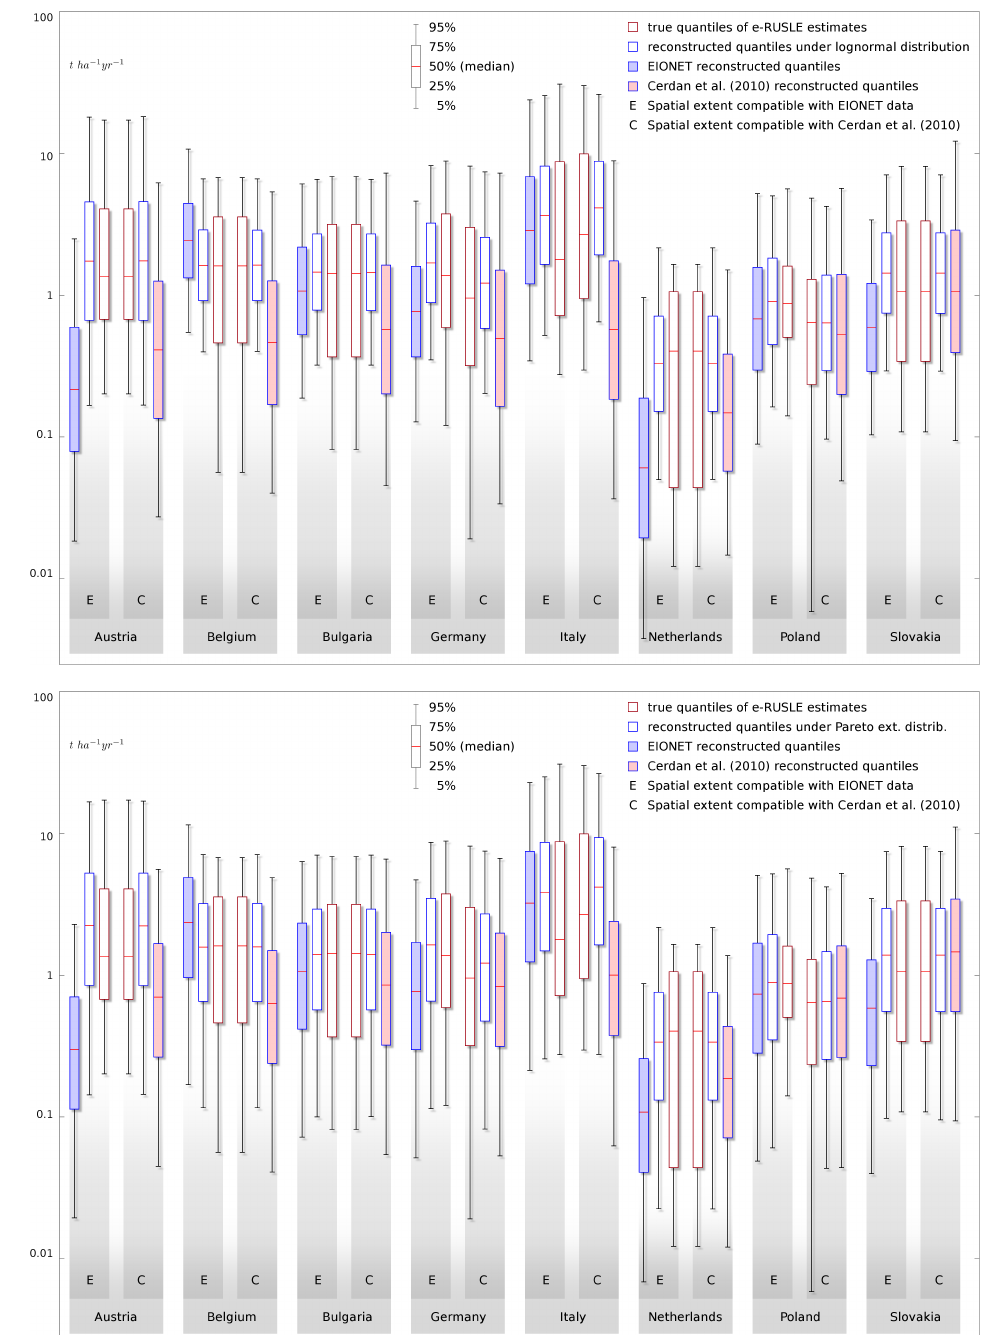
Figure 3. Quantiles (per country) of e-RUSLE estimated soil erosion by water. Boxplots: box with quartiles 25%, 50% (red line), 75%; whiskers with 5 and 95% quantiles. True quantiles are compared with the reconstructed distribution under the hypothesis of lognormal and extended Pareto distribution. The hypothesized distributions are also compared with the ones corresponding to the available statistics from EIONET and Cerdan et al.